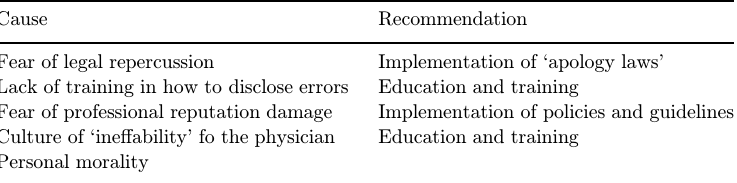
Table 1. Frequently reported causes for not disclosing medical errors and their recommendations for overcoming